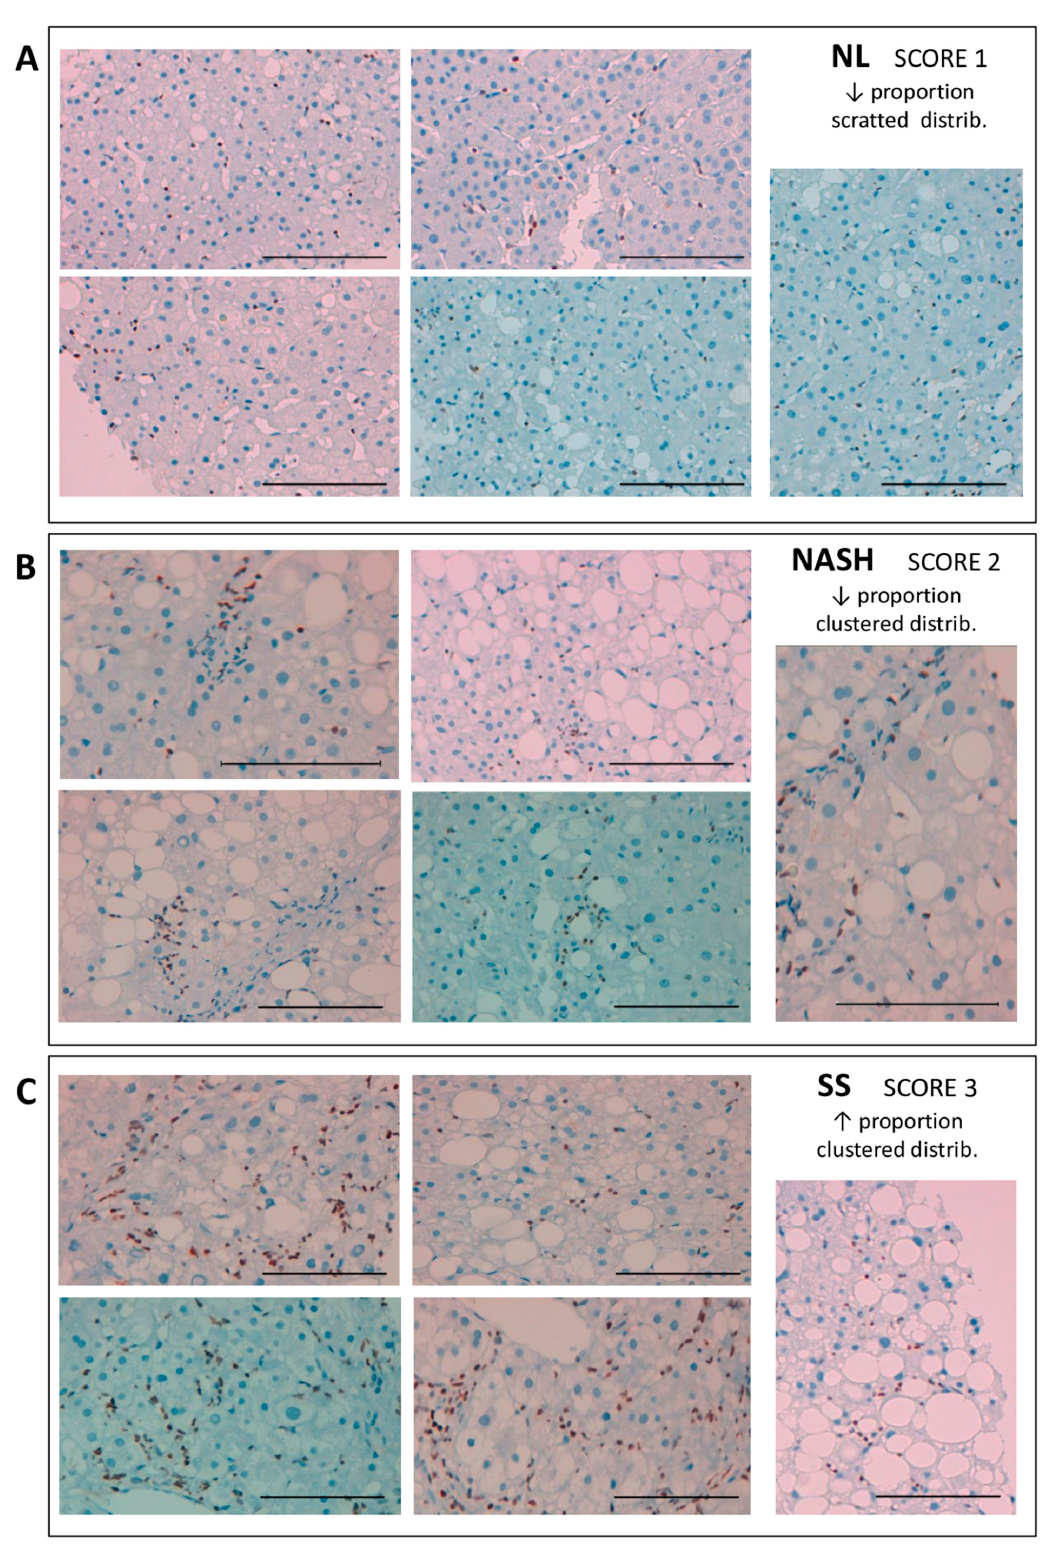
Figure 3. Representative images of the liver biopsies where the immunohistochemical analysis of RUNX1 was carried out. RUNX1 immunostained images (X400) in ( A ) normal liver (NL) samples, ( B ) nonalcoholic steatohepatitis (NASH) samples and ( C ) simple steatosis (SS) samples. RUNX1 positivity was mostly observed in the nonparenchymal cells. Samples were scored (from one to three) according to the RUNX1 positivity proportion (low or high) and distribution (scattered or clustered). Hematoxylin-stained nuclei were distinguishable from RUNX1-positive brown nuclei. Scale bar: 100 µ